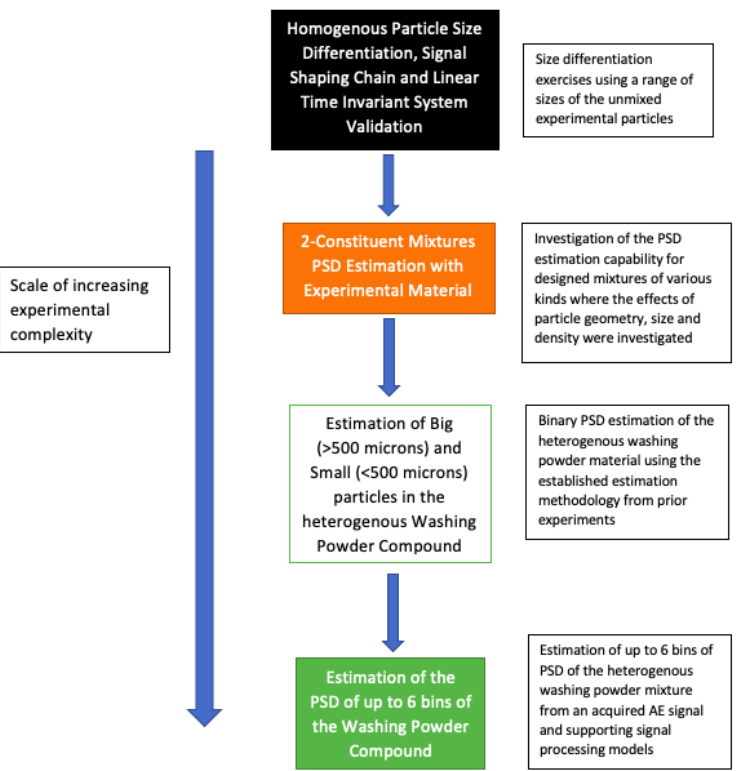
Figure 10. Flow diagram of the experimental pathway.